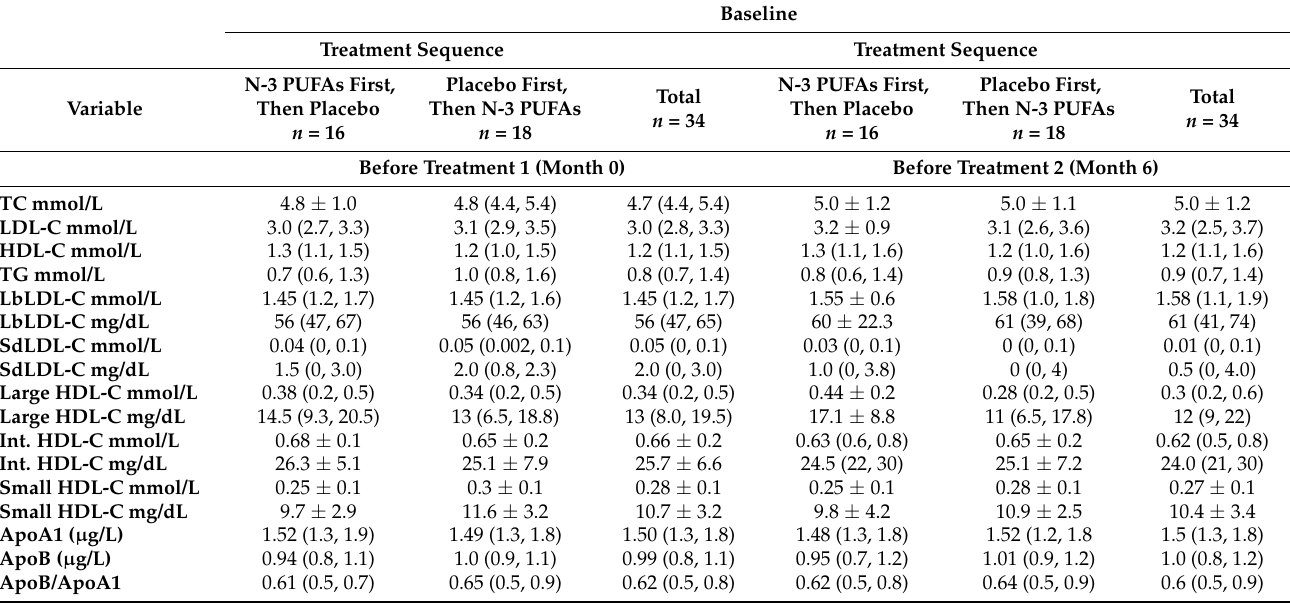
Table 1. Lipoproteins at baseline presented by sequence, treatment period, and total.